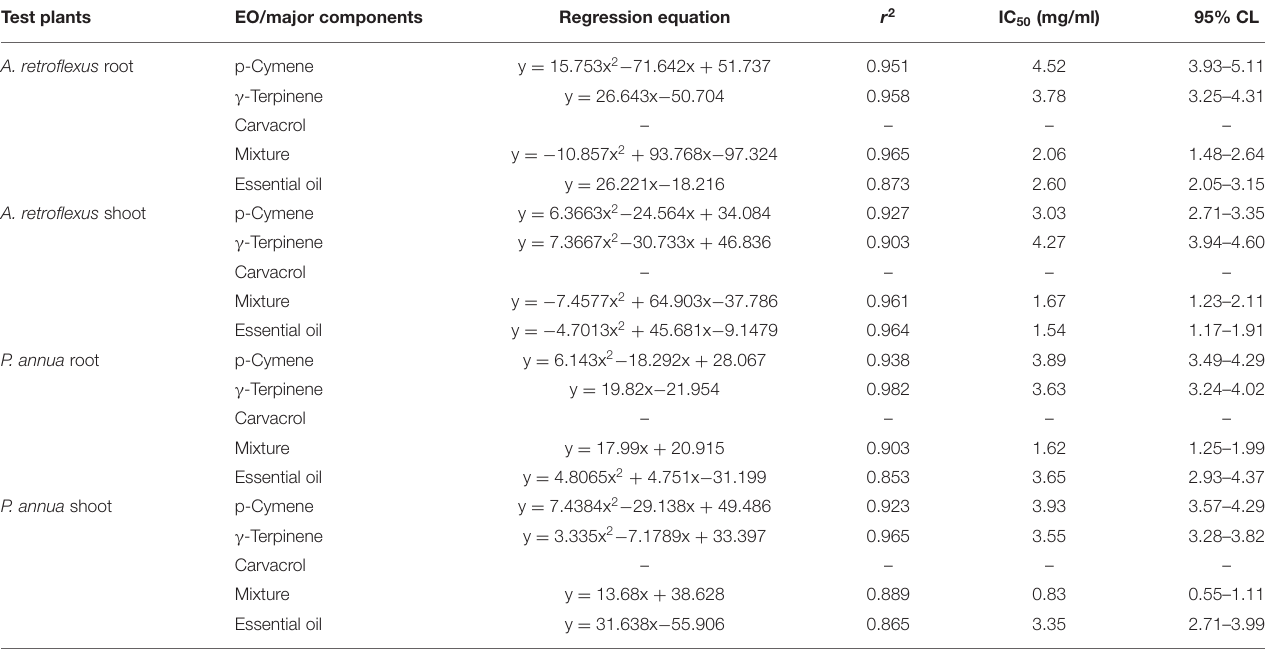
r 2 : adjusted coefficient of determination. IC 50 : the inhibitory concentration required for 50% inhibition. 95% CL: 95% confidence limits. (–): not